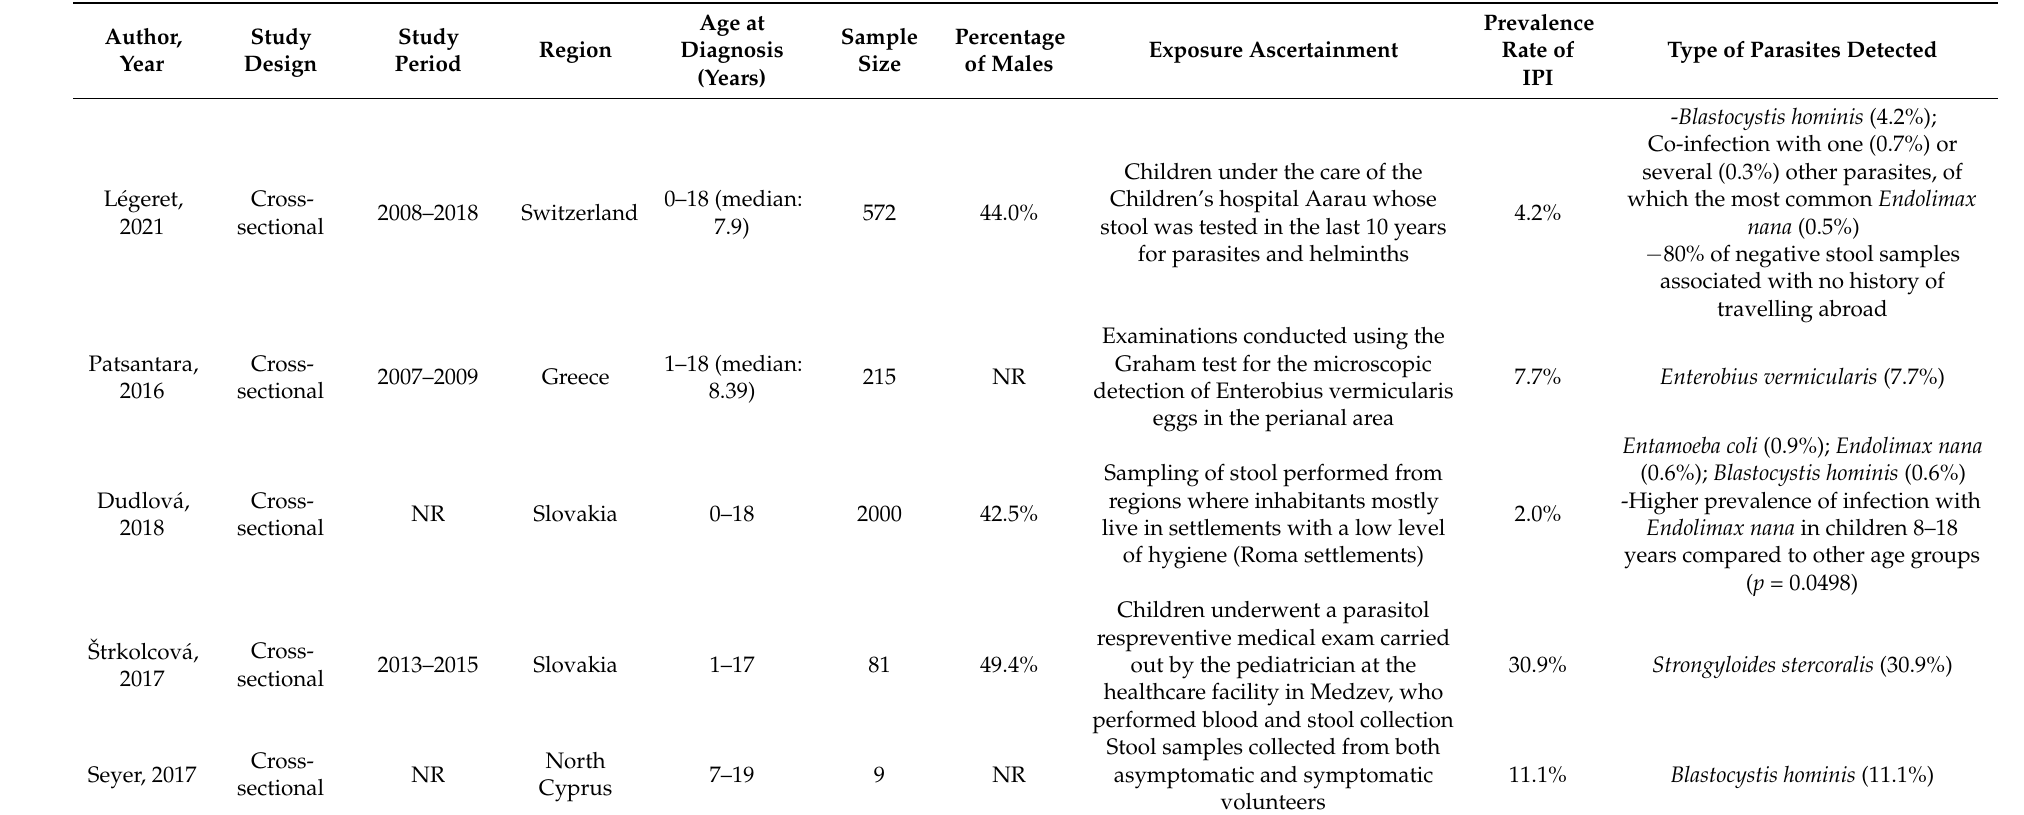
Table 1. Descriptive characteristics and main findings of eligible